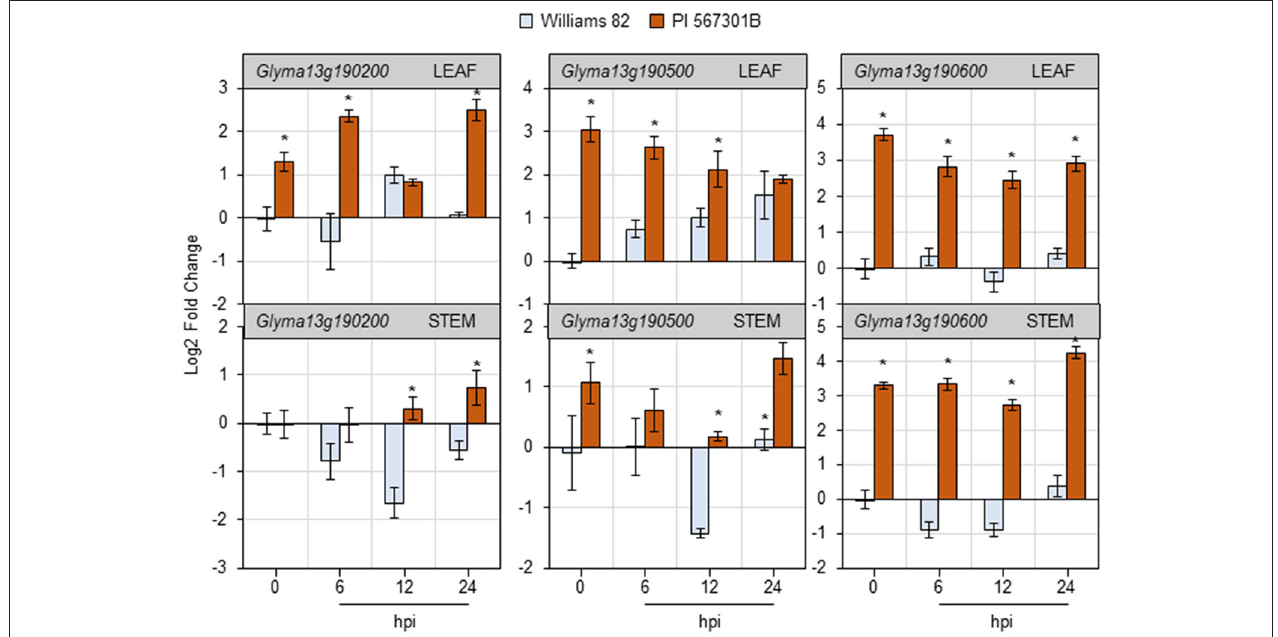
FIGURE 5 | Soybean feeding induces expression of putative Rag5 candidate genes in leaves and stems. Quantitative real-time reverse transcribed PCR (RT-qPCR) to determine the expression of three putative Rag5 candidate genes, Glyma13g190200, Glyma13g190500, and Glyma13g190600, in leaf and stem tissue of Williams 82 and PI 567301B in a time course experiment. The comparative C T method is used to calculate fold change, and all samples are compared with Williams 82 0h (uninfested samples). Data are presented as log2-fold change, and the error bars represent standard deviation ( n = 4). Asterisks above the bars indicate statistically significant differences ( P < 0.05; t